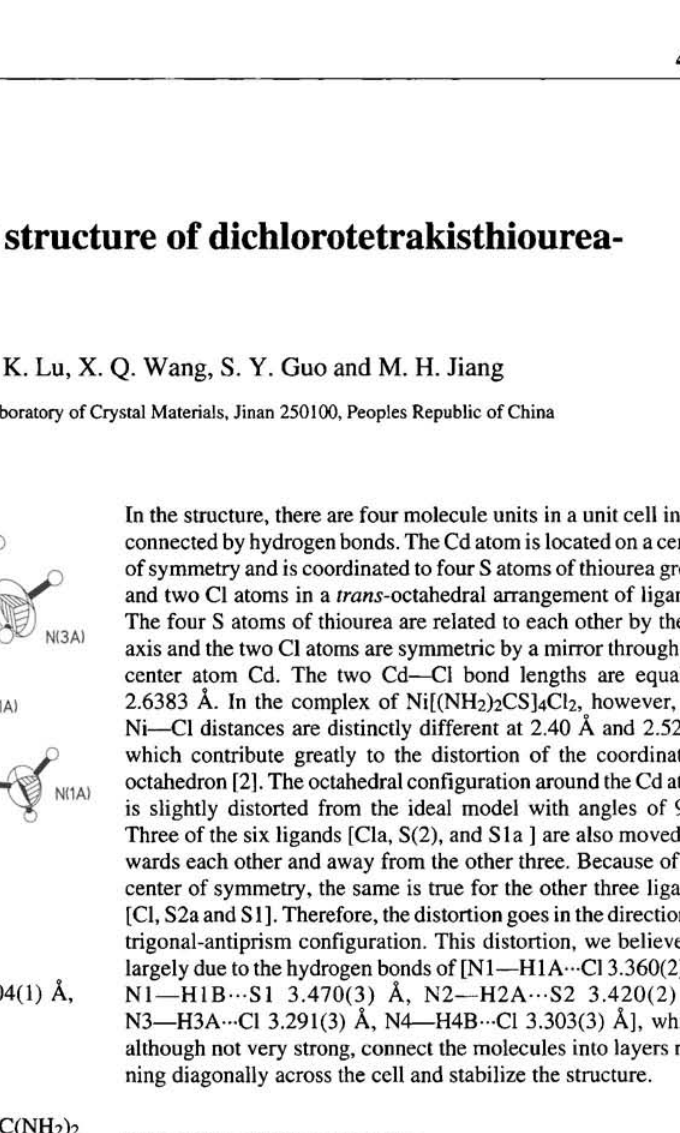
Table 1. Data collection and handling.